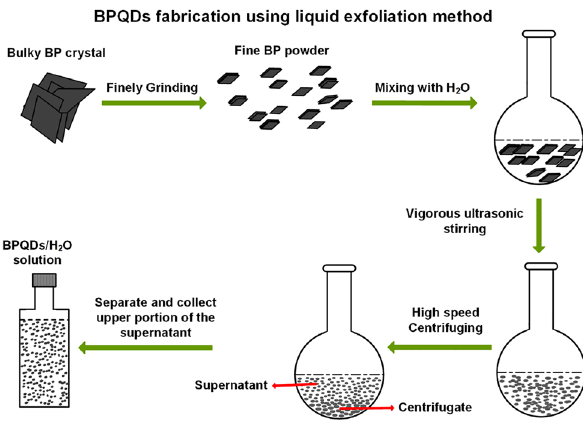
Figure 1: Fabrication process of BPQDs using liquid exfoliation